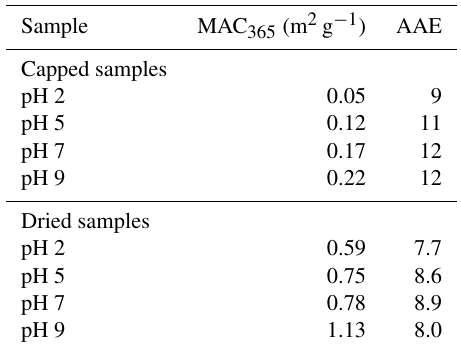
Table 1. Absorptivity (as mass absorption coefficient, MAC) and absorption Ångström exponent (AAE) for dried and capped samples for each initial pH